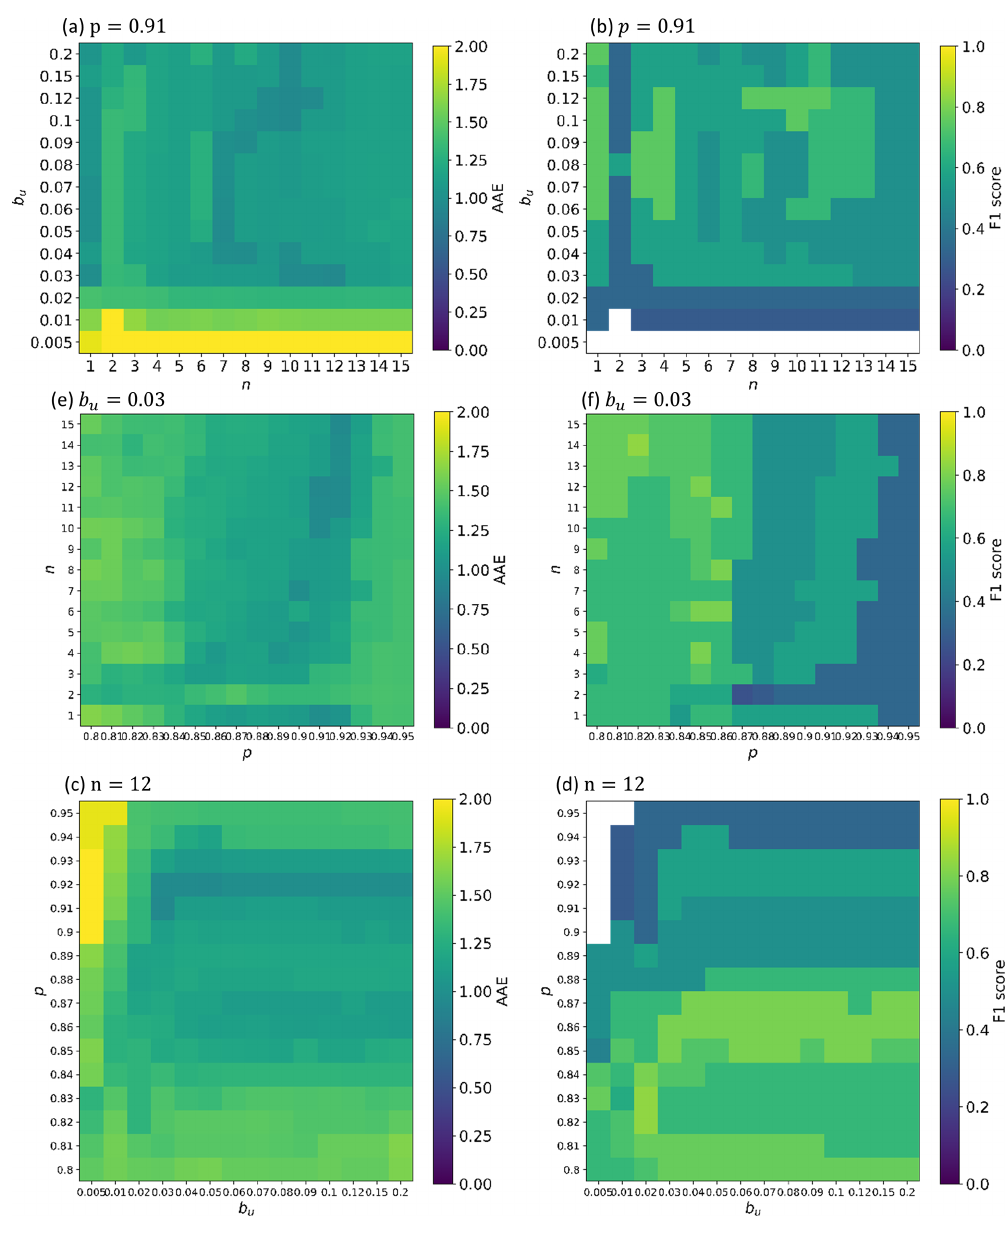
Figure 5. Parameter tuning scenarios. Three algorithm parameters are tuned: the upper bound threshold during extreme value removal b u , the number of comparison dates for each target date n , and the percentage threshold during the plume mask generation p . Two assessment factors are used with focus on different aspects: the average absolute error (AAE) assesses quantification performance, and F 1 score assesses detection performance. A total of 3360 parameter settings were run with wide value ranges of three parameters. Panels (a) and (b) show how AAE and F 1 score change with b u and n , respectively, with p = 0.91; (c) and (d) show how two assessment factors change with n and